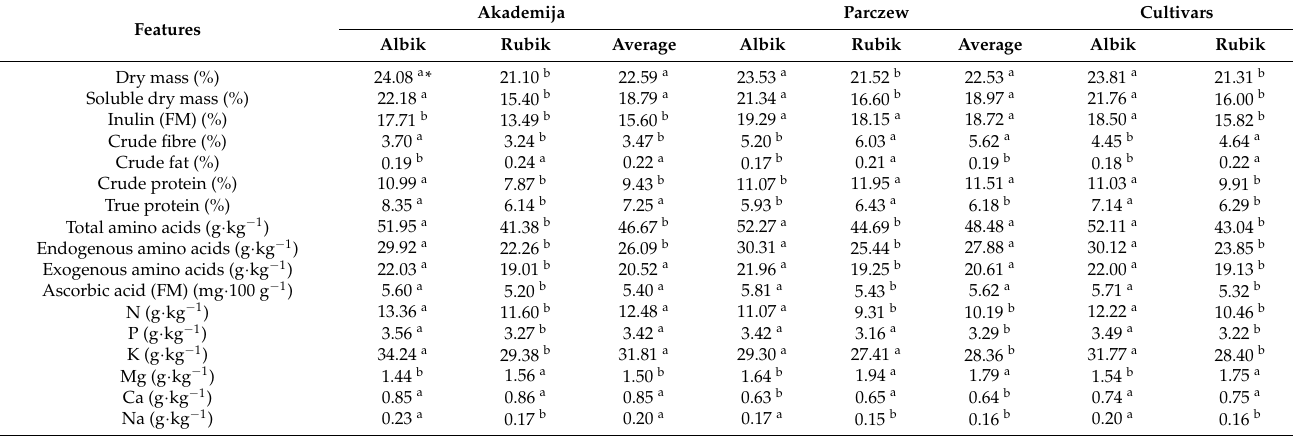
Figure 5. The variability of selected chemical constituents of JA tubers (Mean in g . kg ‐ 1 ).